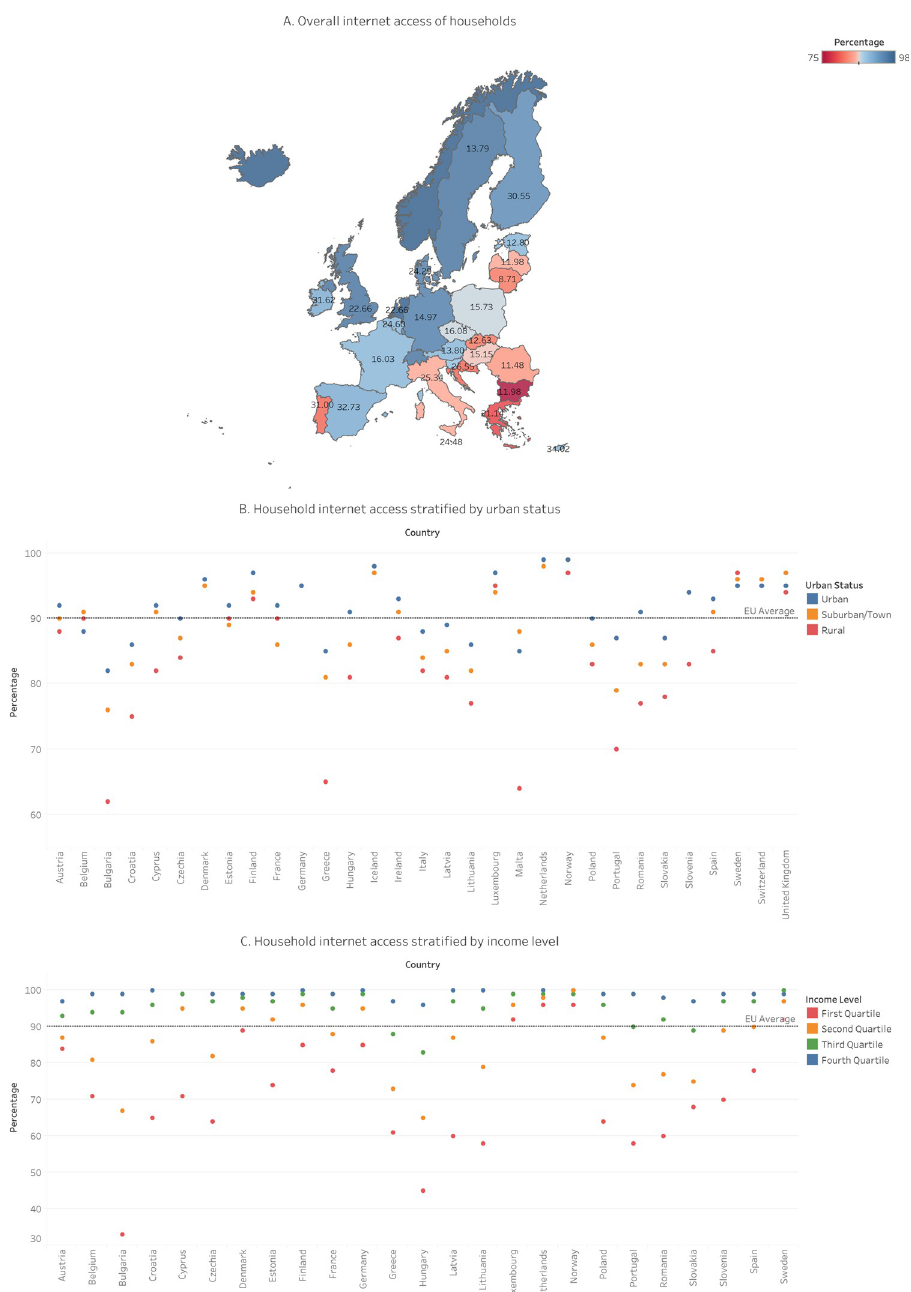
Fig 2. The extent to which European countries have access to the Internet overall and the normalized prices of standalone internet (12-30MB/s, in EUR PPP) (Fig 2A) [30], stratified by urban status (Fig 2B), and by household income level (Fig 2C). The maps were generated in Tableau using OpenStreetMap data (OpenStreetMap Contributors). Figs 2 and 3 indicate that there exists a positive cross-country correlation between the high capital stock and income/earnings and the digital skills development. Moreover, the compara- tive analysis shows that cost of internet access bears marginal influence over digital literacy lev- els. These findings are consistent with the affordability of internet access prices, i.e., with their